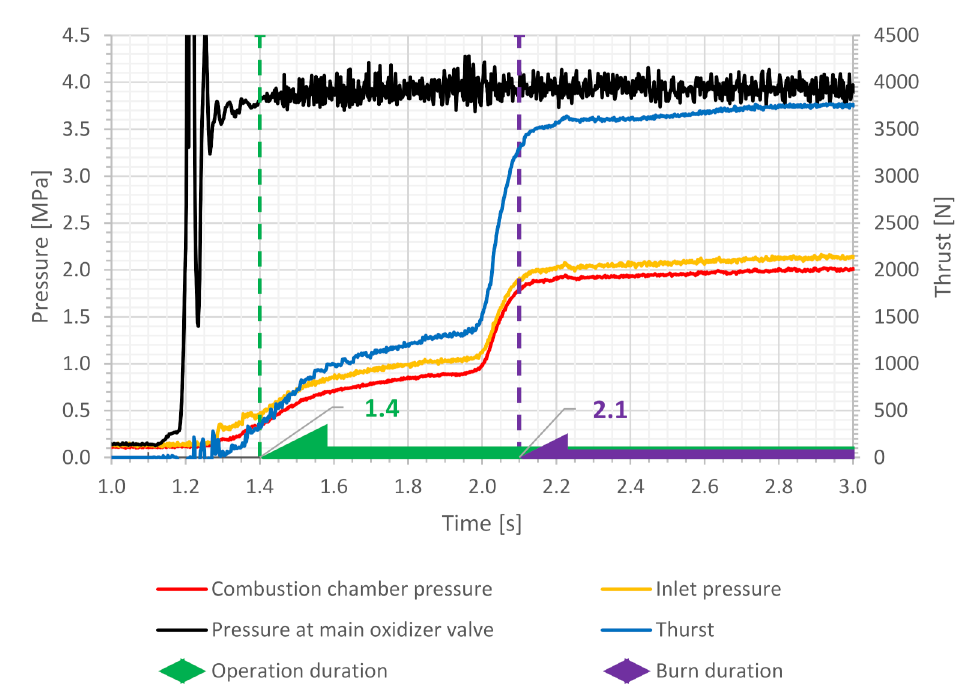
Figure 9. Start-up phase of the Mk2019+ hybrid rocket motor during ground